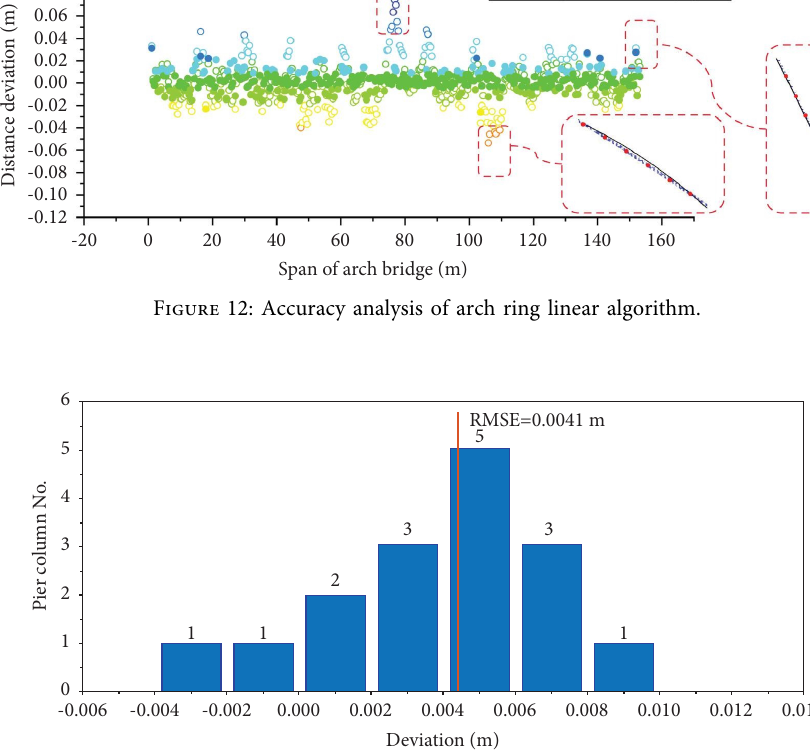
Figure 13: Deviation of the intersection relative to the design